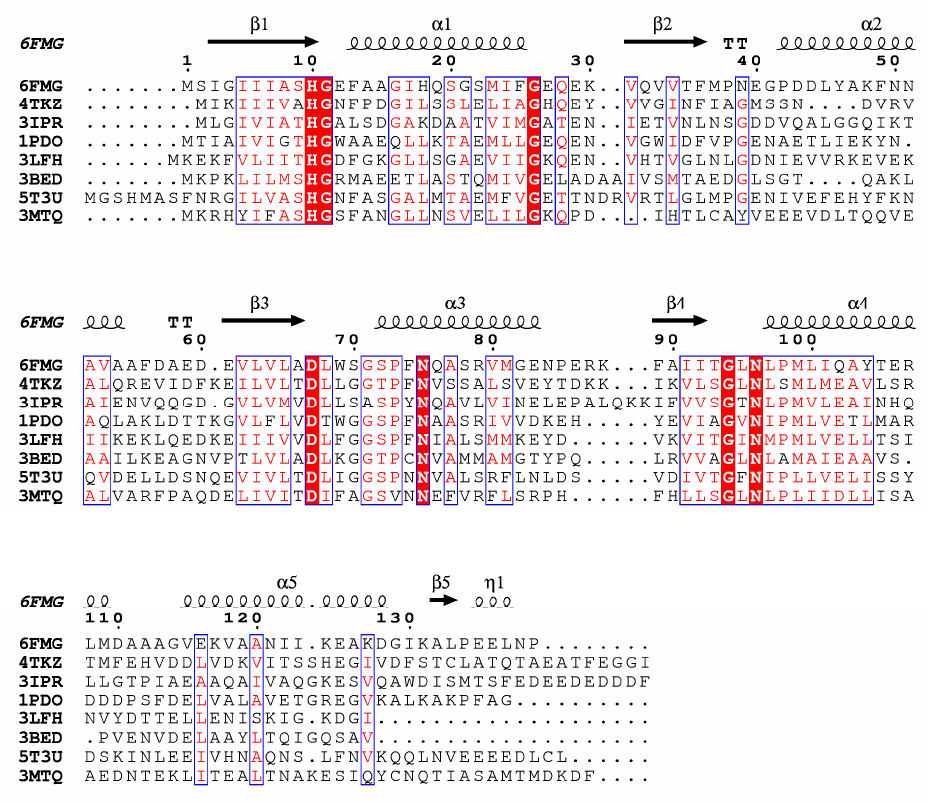
Figure 6. Amino acid sequence alignment of EIIA-Man domains of mannose transport proteins, for which structures have been reported. PDB codes and sources of EIIA subunits are as follows: 6FMG— Streptococcus pneumoniae (structure characterized in this study), 4TKZ— Streptococcus agalactiae , 3IPR— Enterococcus faecalis , 1PDO— Escherichia coli, 3LFH— Thermoanaerobacter tengcongensi s, 3BED— Enterococcus faecalis , 5T3U —Streptococcus pneumoniae, 3MTQ— Klebsiella pneumoniae . Strictly conserved residues are highlighted by red background while homologous residues are depicted in red. Secondary structure elements are indicated above the alignment. The figure was prepared